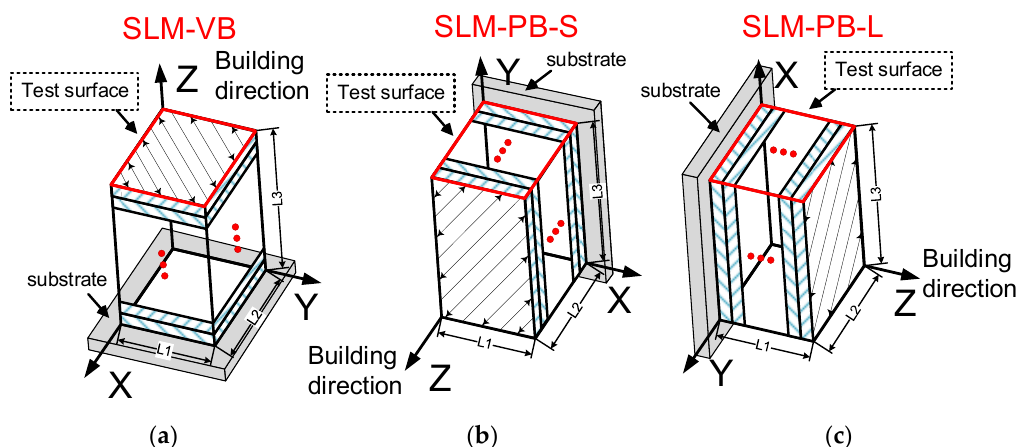
Figure 3. Samples fabricated by SLM in different building orientations. ( a ) SLM-VB; ( b ) SLM-PB-S; ( c ) SLM-PB-L. Table 2. The specific parameters in SLM.